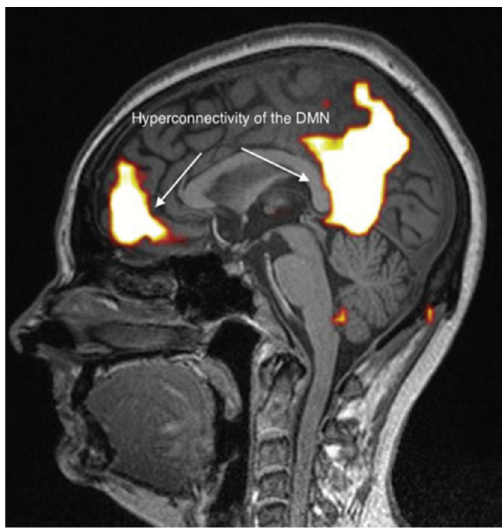
Figure 4. Abnormal functional MRI brain scan in patients complaining of EHS after long-term exposure to EMF, according to Reference [31].